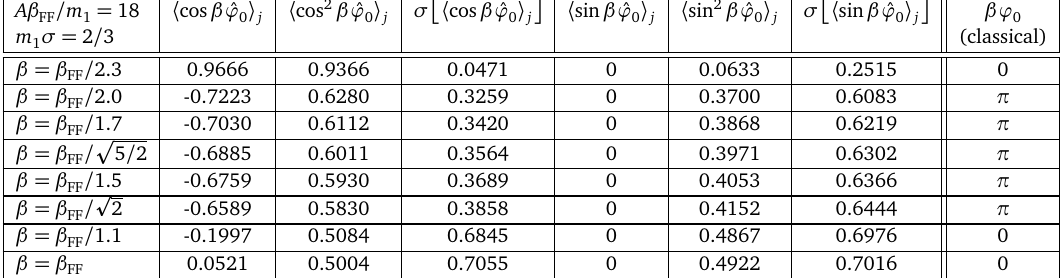
Table 4.1: The zero mode in the quantum inhomogeneous state from TCSA with = 30, and in the classical lowest energy configuration (last column) when e c m L = 20, m = m 1 homogeneous initial state, while σ the